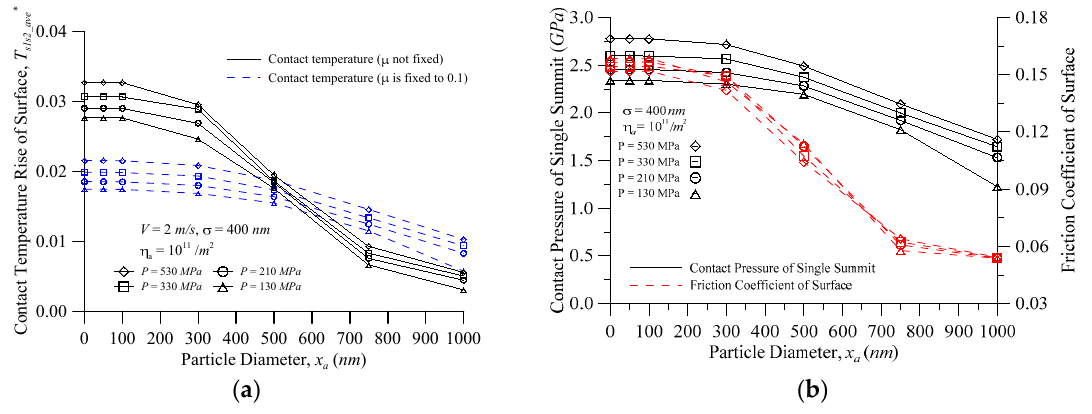
Figure 5. The characteristics of the surface vs. the particle diameter at various contact pressures for ( a ) the contact temperature rise; and ( b ) the contact pressure of a single summit and the coefficient of friction.